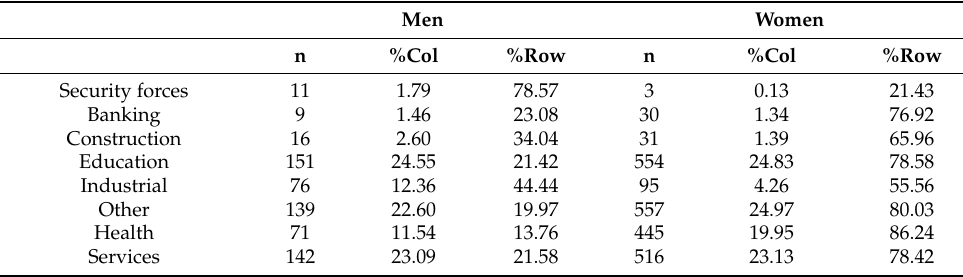
Table 2. Relationship between profession and